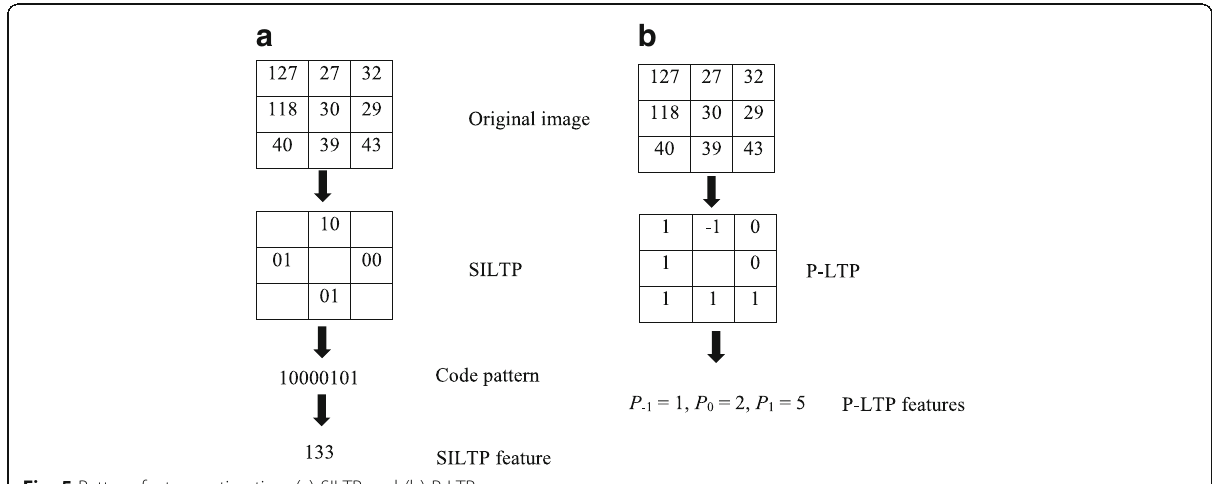
Fig. 5 Pattern feature estimation: (a) SILTP and (b)